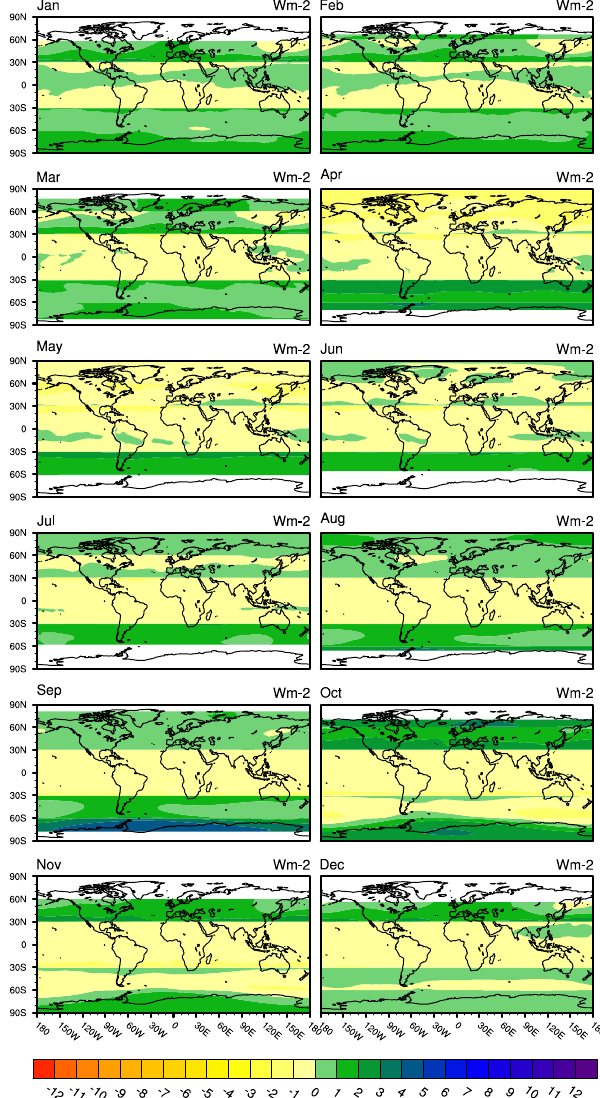
Figure 8. Bias in the ozone absorption using the MSR monthly av- erages for the period (1979–2008) as a baseline for New